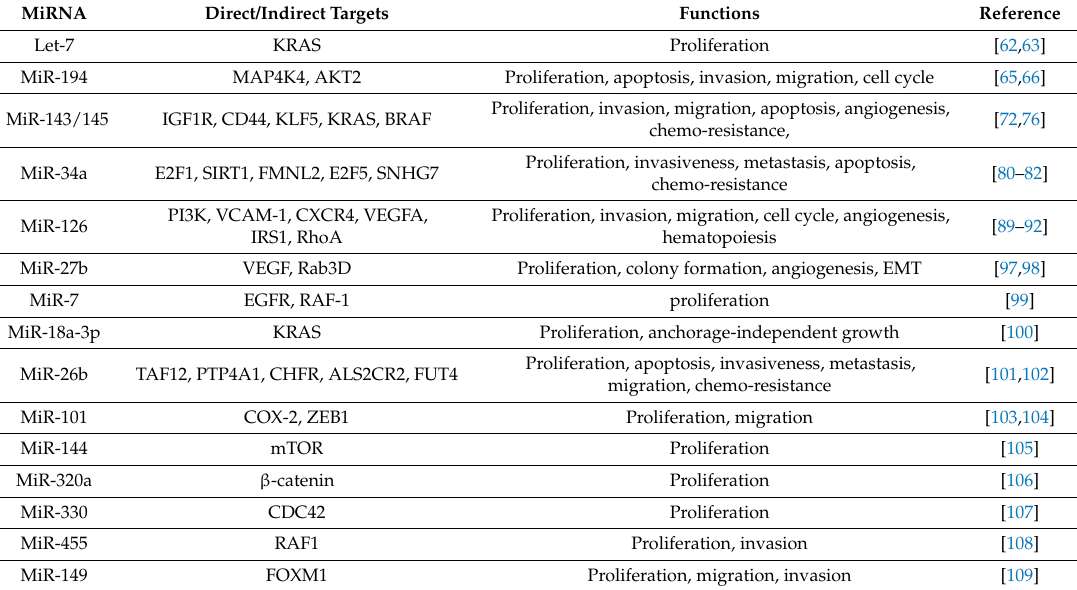
Table 2. The down-regulated tumor-suppressive miRNAs in